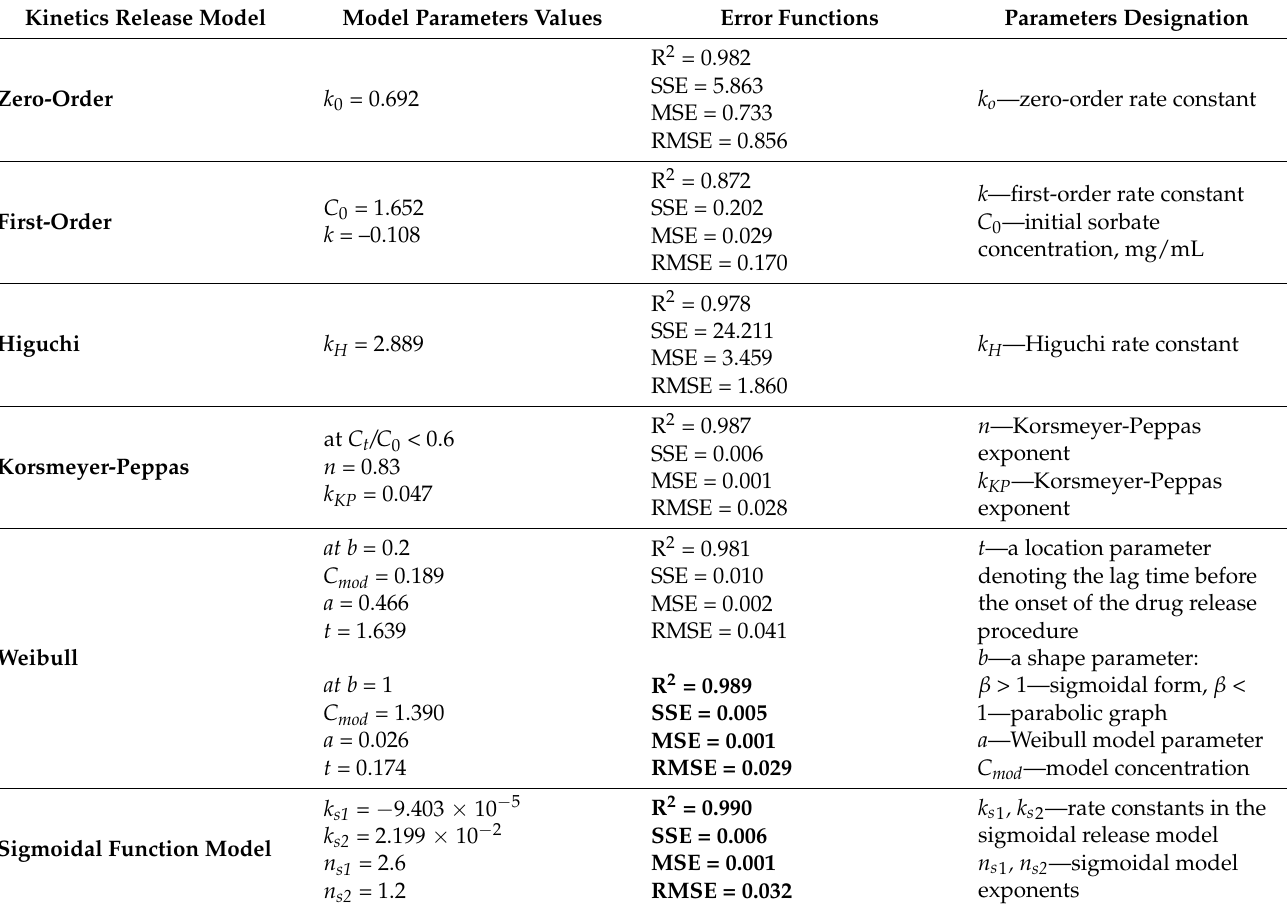
Table 2. Kinetics models of catechin in vitro release model parameters and error functions values. Kinetics Release